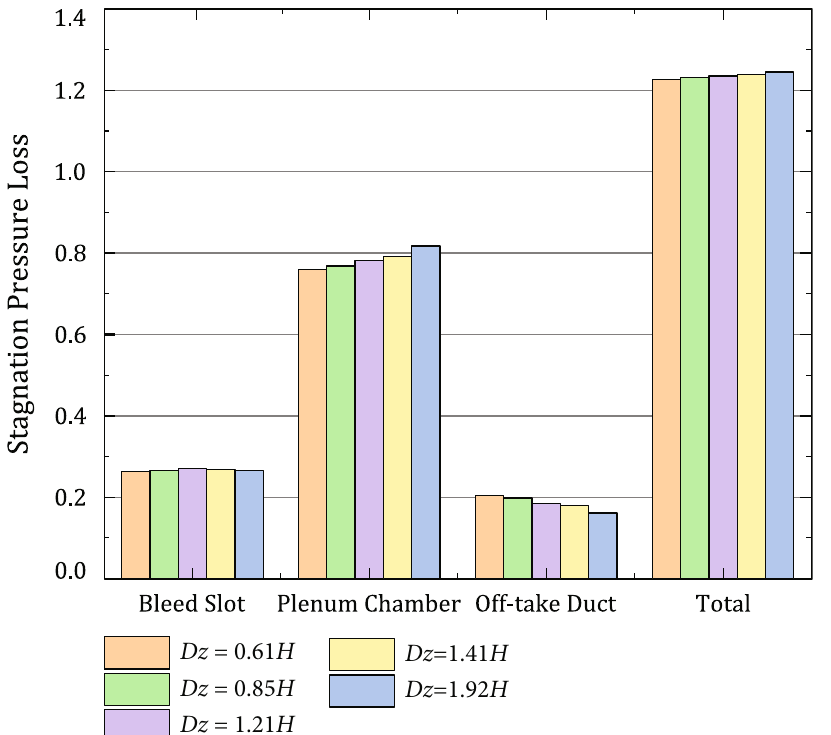
Figure 14: SPL coe ffi cient for each part with di ff ering axial